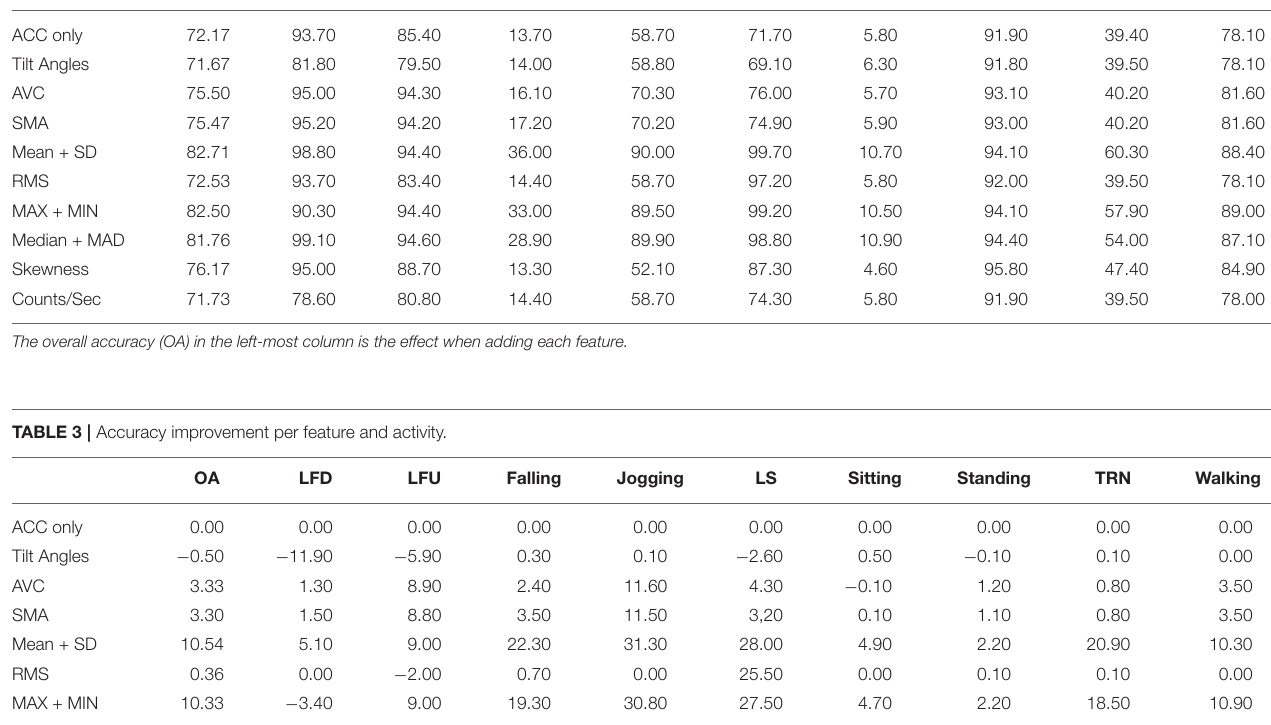
TABLE 2 | Total accuracy per feature (or pairs of features) per activity compared to just using accelerations (ACC) only. OA LFD LFU Falling Jogging LS Sitting Standing TRN Walking